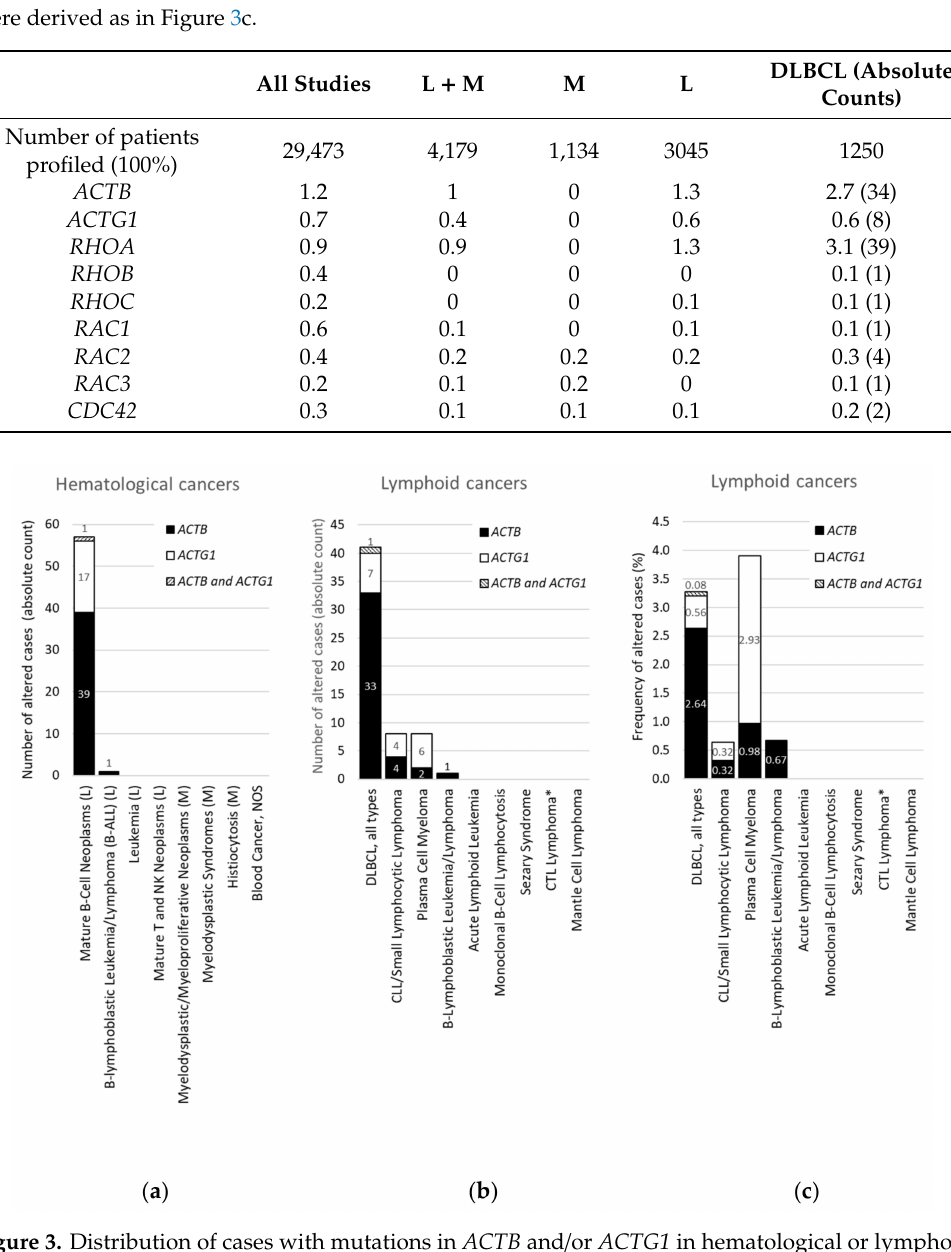
Figure 3. Distribution of cases with mutations in ACTB and / or ACTG1 in hematological or lymphoid malignancies. ( a ) Absolute counts in hematological cancers (ranked and sorted by cancer type), ( b ) absolute counts in lymphoid cancers (ranked and sorted by cancer type detailed), ( c ) frequency in lymphoid cancers (for comparison sorted as in ( b )). L = lymphoid cancer, M = myeloid cancer, DLBCL = di ff use large B-cell lymphoma, NOS = not otherwise specified, CLL = chronic lymphocytic leukemia, CTL = cytotoxic T-cell, plasma cell myeloma = multiple myeloma. * CTL Lymphoma = Primary Cutaneous CD8 + Aggressive Epidermotropic CTL Lymphoma. Data on ‘DLBCL, all types’ in ( b , c ) were originally derived from three subtypes in cBioPortal and grouped here. Information derived from the Cancer Type Summary